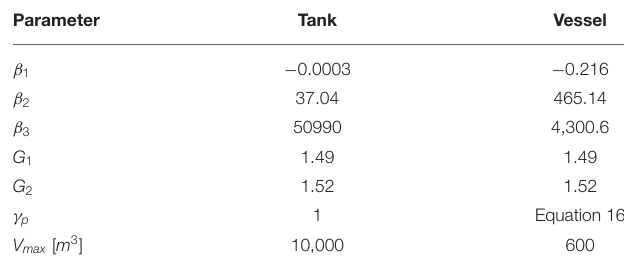
TABLE 5 | TES cost correlation parameters (Equation